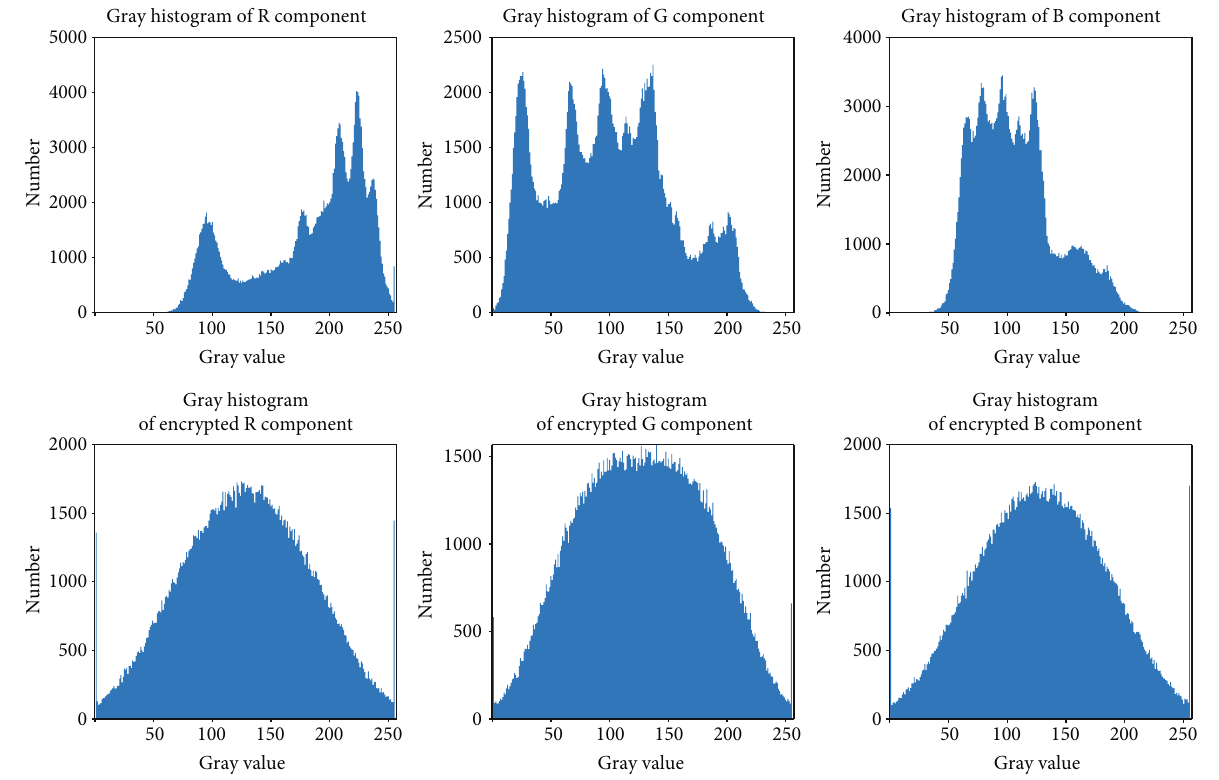
Figure 5: Histogram of each color component of airplane plaintext image and ciphertext image. Table 1: Correlation coe ffi cients of adjacent pixels of plaintext and